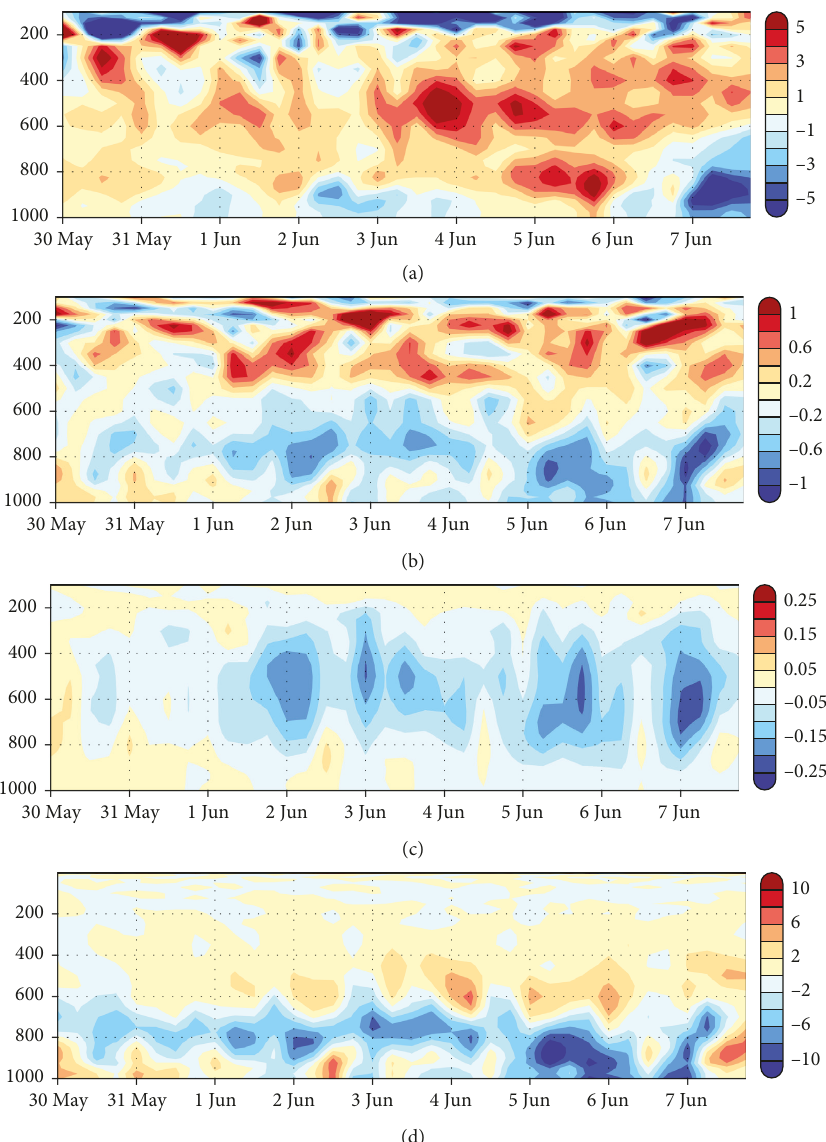
1 ), (b) divergence of the horizontal wind (10 day · 5 1 1 ) averaged over the SP region, from May 30 to June 07, 2016, g kg s − · · · − − −